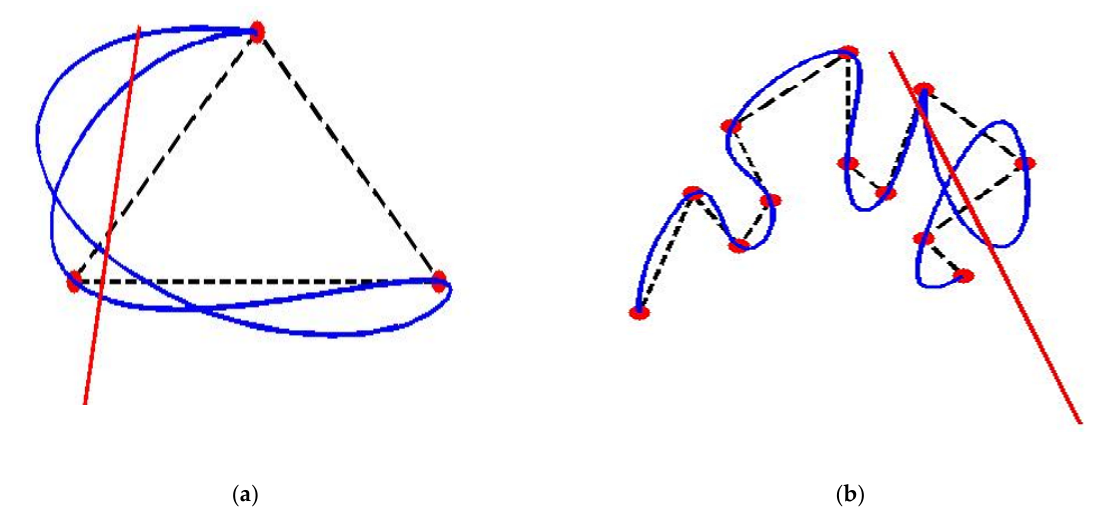
Figure 6. VD property violates at different intervals for the values of shape parameters ( a ) ρ k = − 1, in 3rd interval and ( b ) σ i = − 0.5 for the 3rd